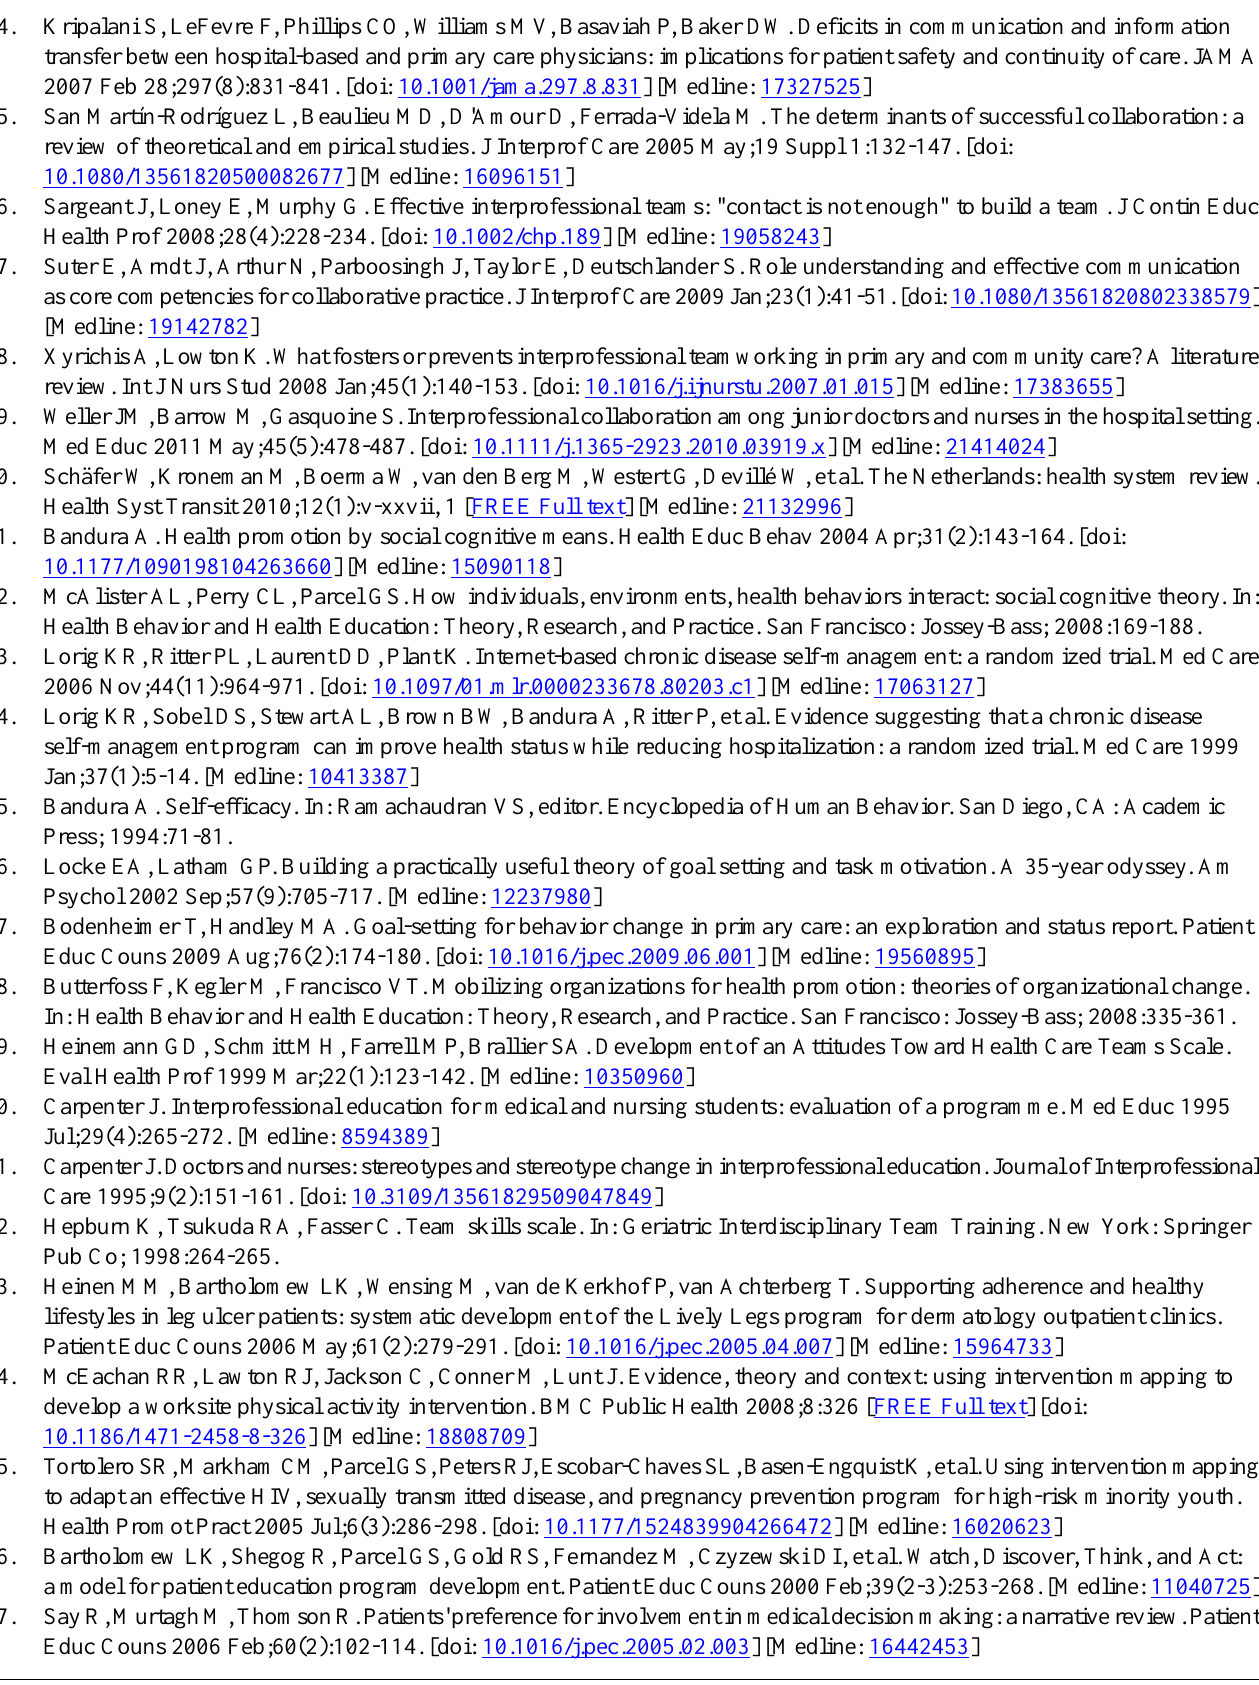
Abbreviations EHR: electronic health